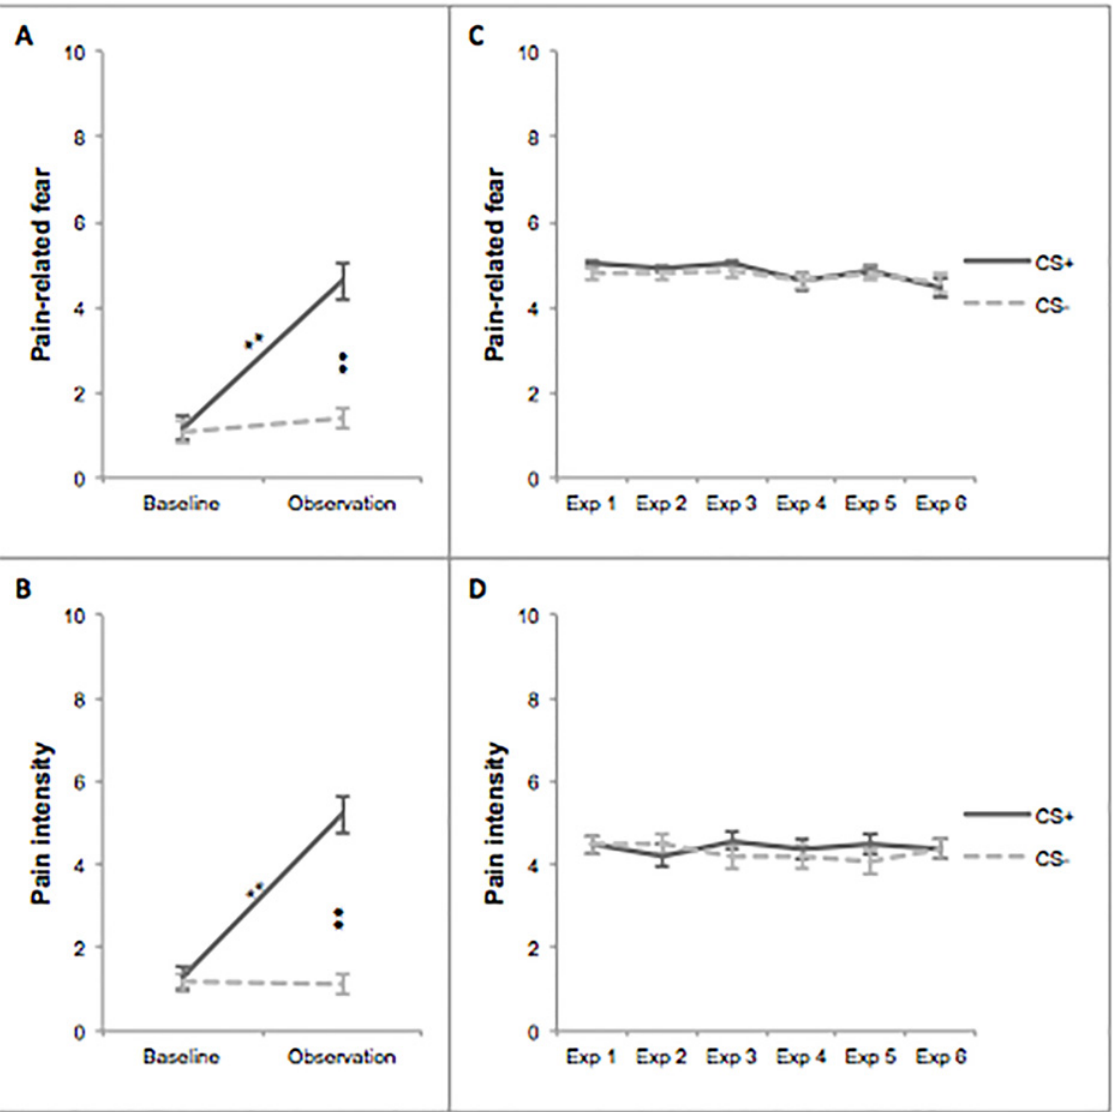
Fig 4. Self-reports: Pain-related fear and pain intensity in Experiment 2. Error bars represent standard errors. Exp = Exposure; * p < .05; ** p <